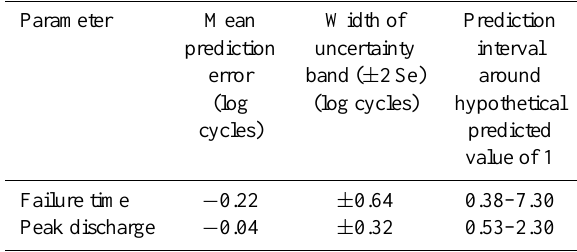
Table 5. Mean prediction errors for failure time and peak flow, width of uncertainty bands, and prediction interval (for hypothet- ical value of 1) using Froehlich’s equations (Wahl,